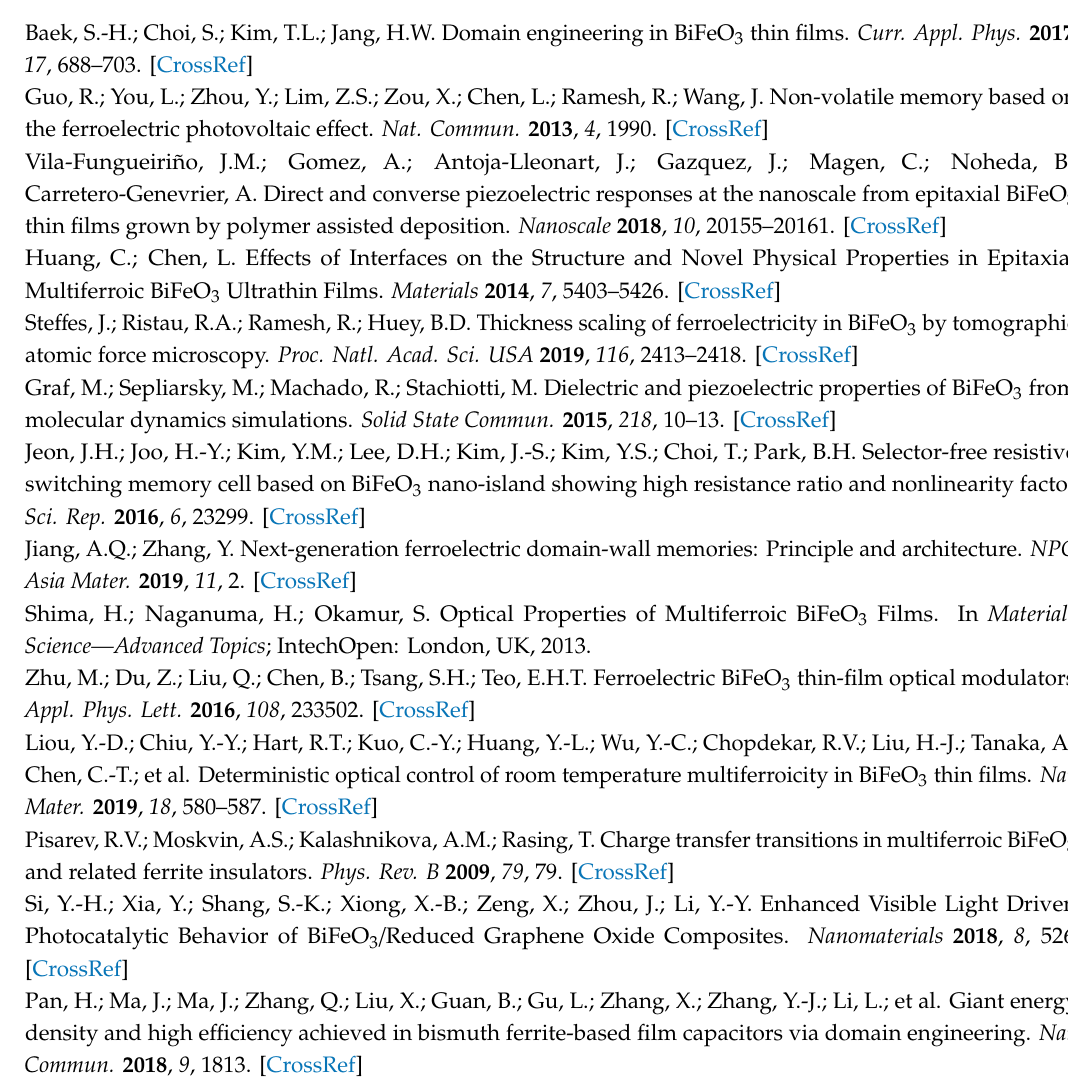
Table S1: XPS spectra of Fe 2p, Bi 4f, O 1s, C 1s components depending on the annealing